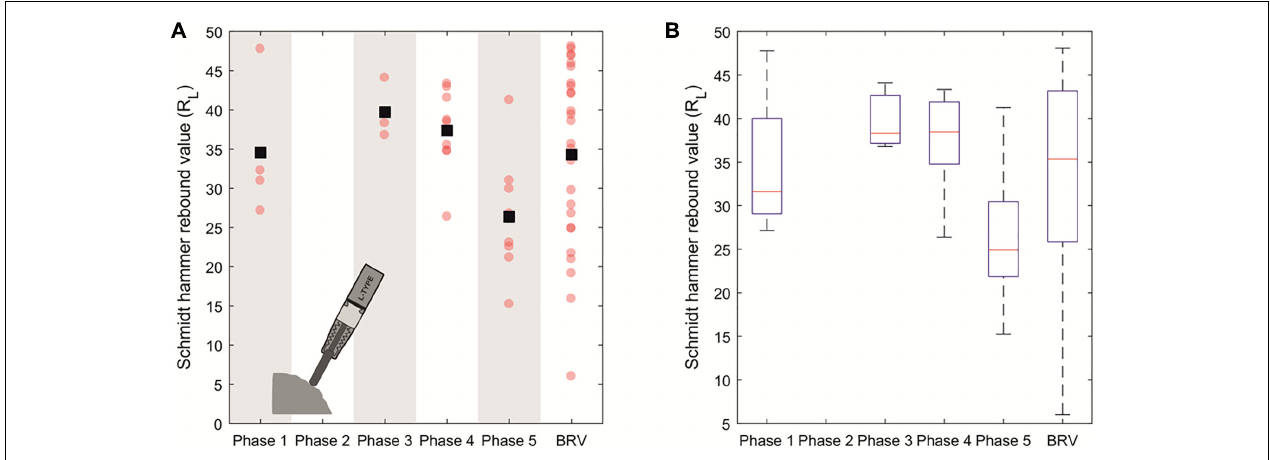
FIGURE 5 | (A) Schmidt hammer rebound value ( R L ) results from field testing at sampling locations for Phases 1, 3, 4, and 5. Belham River Valley (BRV) results show values obtained on a random selection of blocks from Phases 3, 4, and 5. Raw data shown by circles, with the mean R L for each phase shown by a square; (B) box plot diagram to show median (red line), mean (black squares), 25th and 75th percentiles, and range for Schmidt hammer rebound values from each phase. Results from BRV span the overall range in values seen in other phases and highlight that Phase 5 material is the weakest of the erupted products tested, although the maximum R L across all phases is similar.